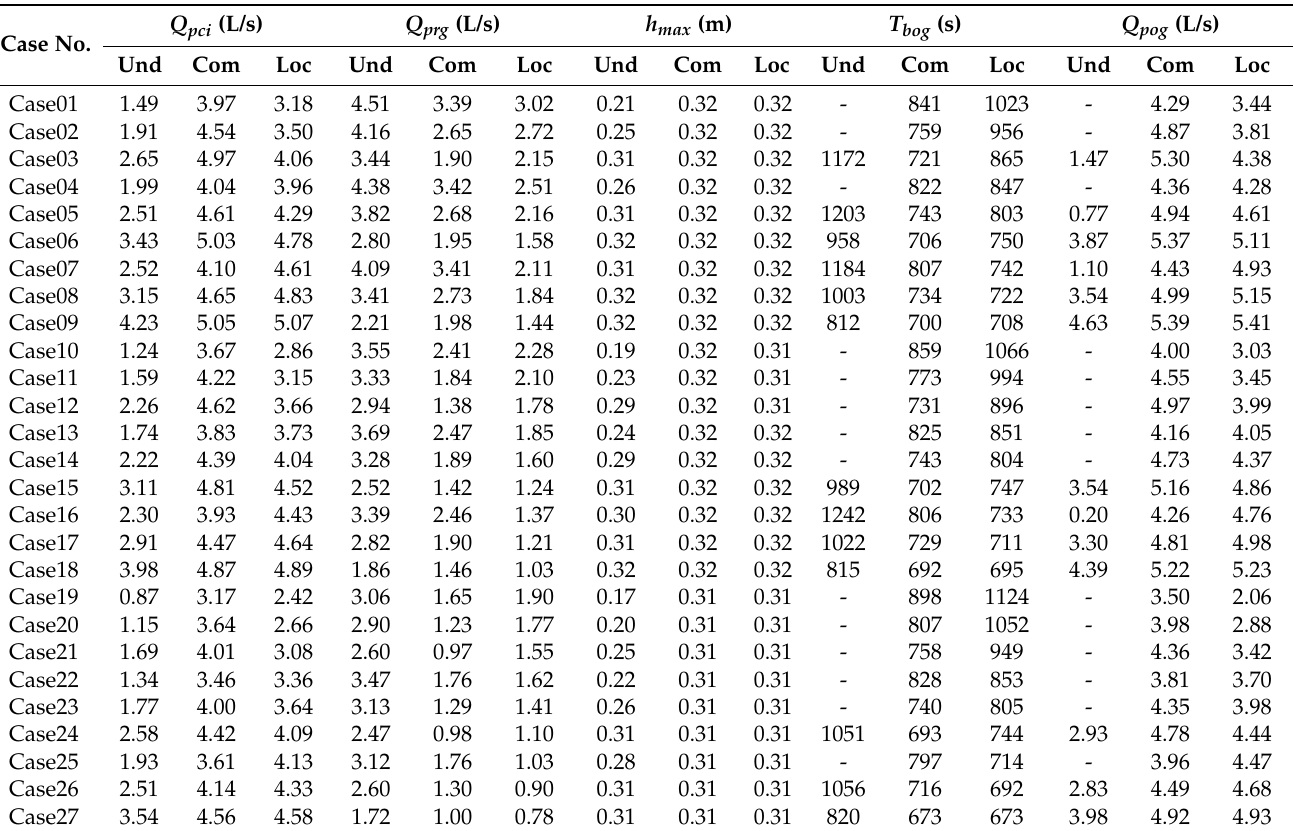
Table 3. Simulation discharge results of all road-bioretention